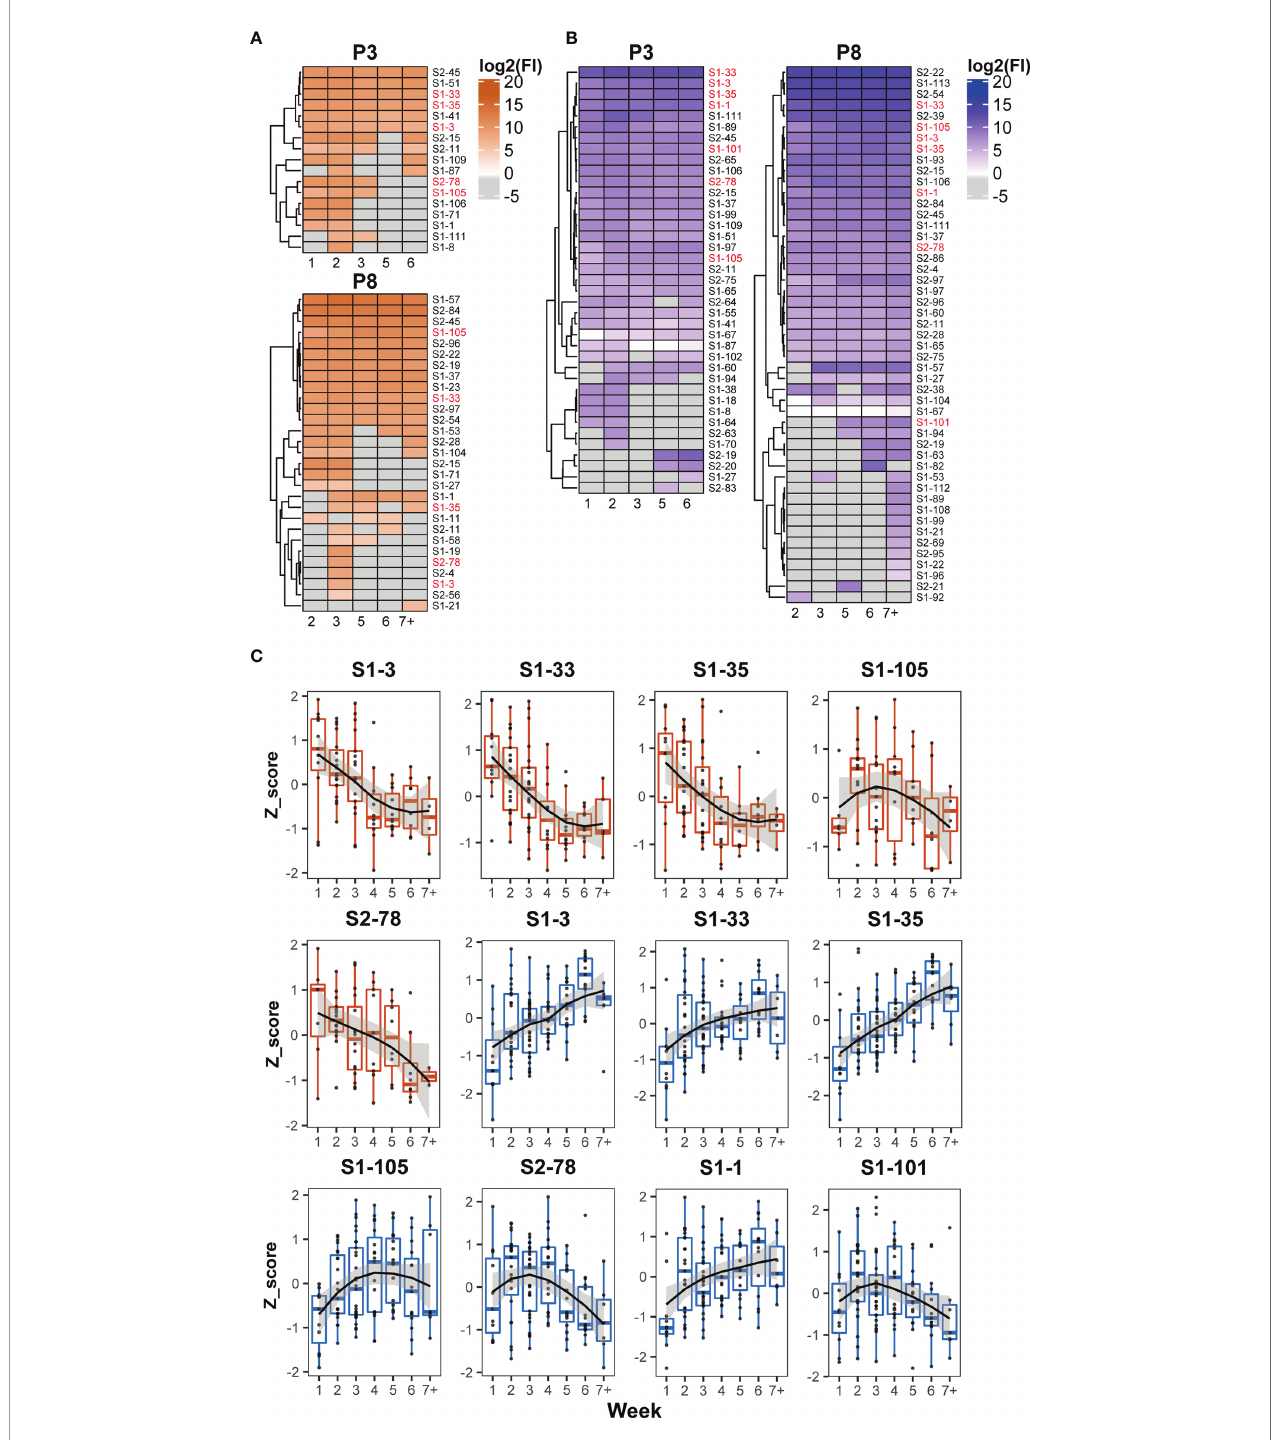
FIGURE 3 | Dynamic patterns of humoral immune responses against reactive S peptides in the COVID-19 patients. Heatmaps of IgM (A) and IgG (B) against S- reactive peptides during hospitalization in the sera of two COVID-19 patients, P3 and P8. The gray cells on the heatmaps indicate signals with values lower than the cutoffs. The x axis of heatmap indicates the time intervals (week) during the hospitalization after symptom onset. (C) The dynamic changes of IgM (boxplot colored in orange) and IgG (boxplot colored in blue) against fi ve IgM-reactive S peptides recognized in at least 50% patients and seven IgG-reactive S peptides recognized in all patients. The signals were normalized by the Z-score and the signal patterns were mimicked by curve fi